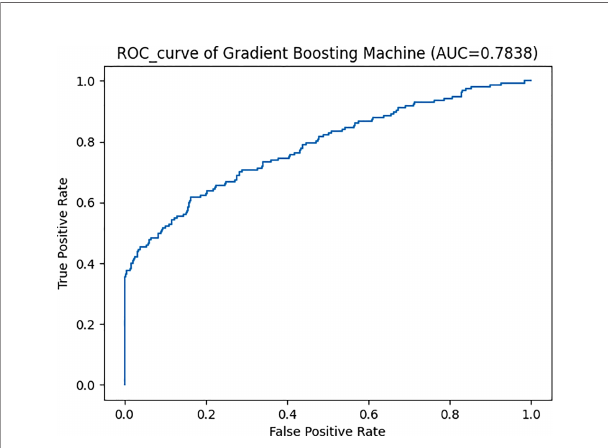
FIGURE 2 | The area under the receiver operating characteristic curve (AUROC) of gradient boosting machine algorithm for the prediction of precocious puberty. AUC, area under the receiver operating characteristic curve; ROC, receiver operating characteristic